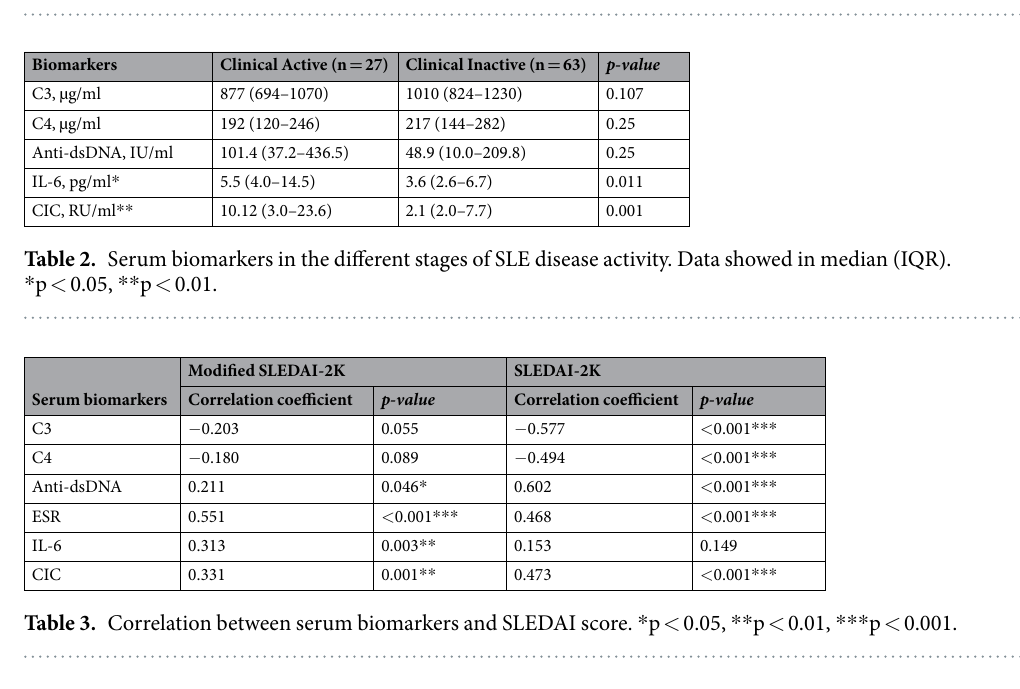
(Table 5). Also, the combination of IL-6 or CIC demonstrated the highest odds ratio of predicting active clinical SLE compared to the combination of complement or anti-dsDNA (OR = 7.27, 95%CI (1.99–26.63), p = 0.003 vs. OR = 3.14, 95%CI (1.16–8.48), p = 0.024) (Table 5). Although ESR showed a moderate degree of correlation with IL-6 (Table 4), the combination of ESR and CIC did not show a significant OR in predicting active disease (OR = 3.45, 95%CI (0.93–12.87), p = 0.065) (Table 5 ) . Also, seven out of twenty-seven of active clinical SLE cases showed normal levels of complement and anti-dsDNA. Up to 85% (6/7) had either elevated CIC or IL-6. The clinical manifestations included rash, lym- phopenia, autoimmune hemolytic anemia (AIHA), psychosis, myelitis and mild lupus nephritis (Table 6).